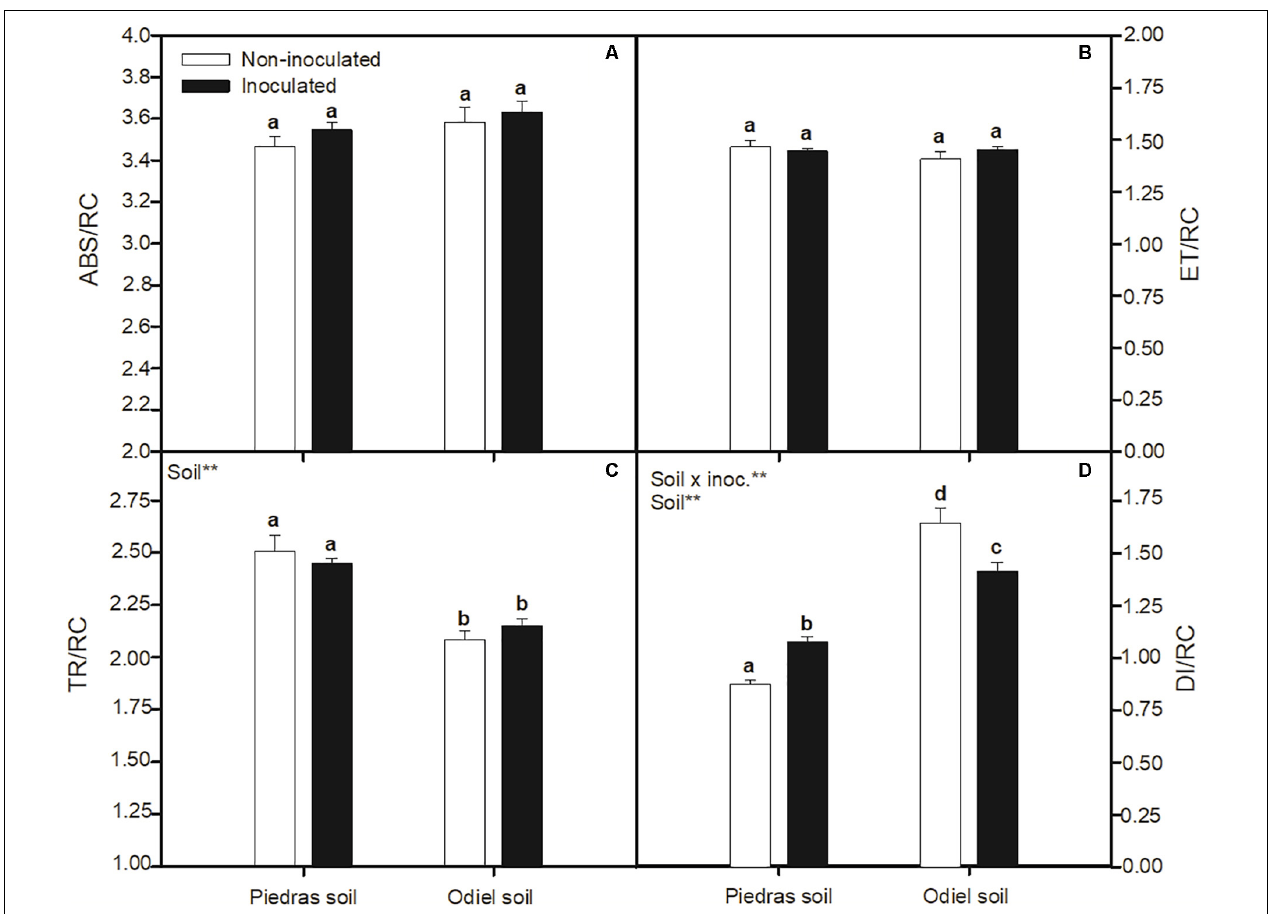
FIGURE 4 | Effect of soil bioaugmentation on S. ramosissima (A) ABS/RC, (B) ET/RC, (C) TR/RC, and (D) DI/RC after 30 days of treatment. Values are means ± S.E. ( n = 10). “Inoc” or “Soil” in the upper left corner of the panel indicates main or interaction significant effect (** p < 0.01). Different letters indicate means that are significantly different from each other ( p < 0.05).